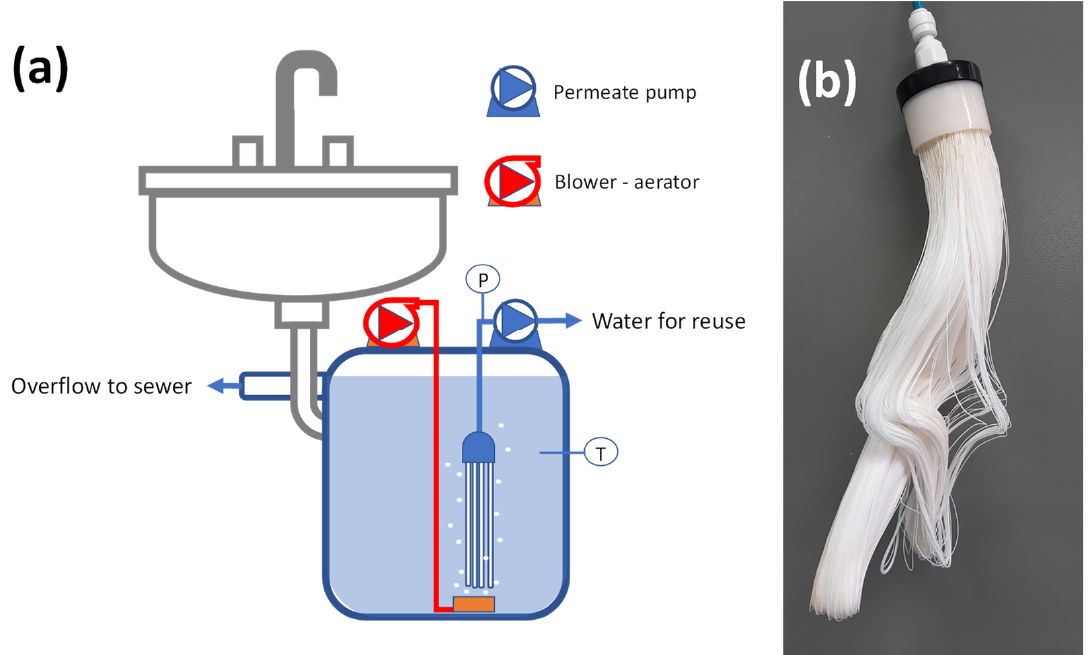
Figure 1. ( a ) Schematic representation of the experimental setup and ( b ) photographic representation of the hollow-fiber membrane module, used for this study.